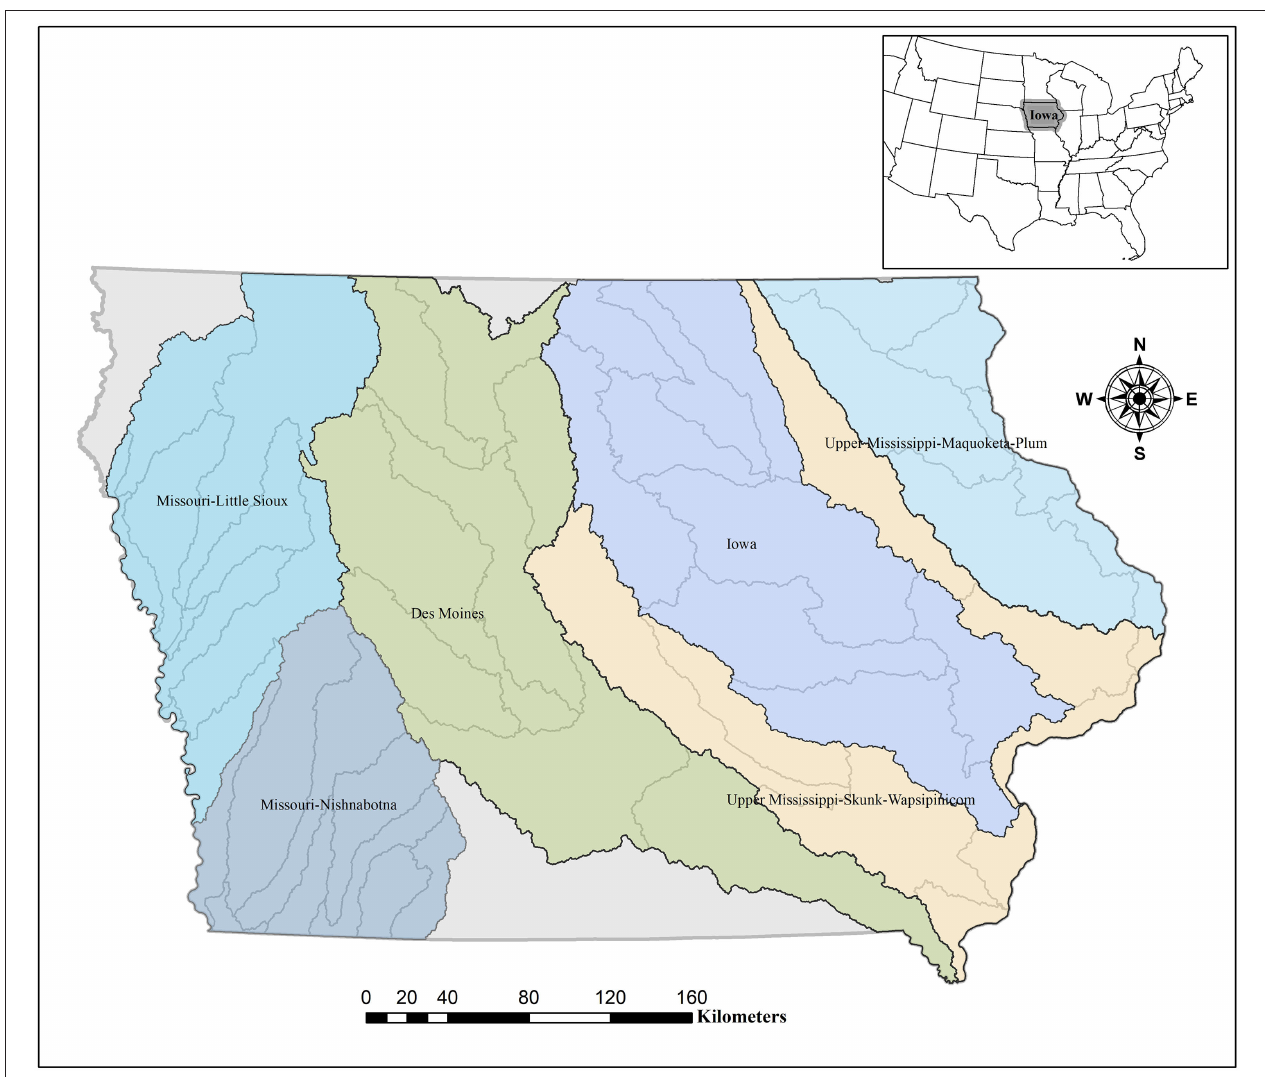
FIGURE 1 | Six HUC6 watersheds surveyed between 2015 and 2019 in